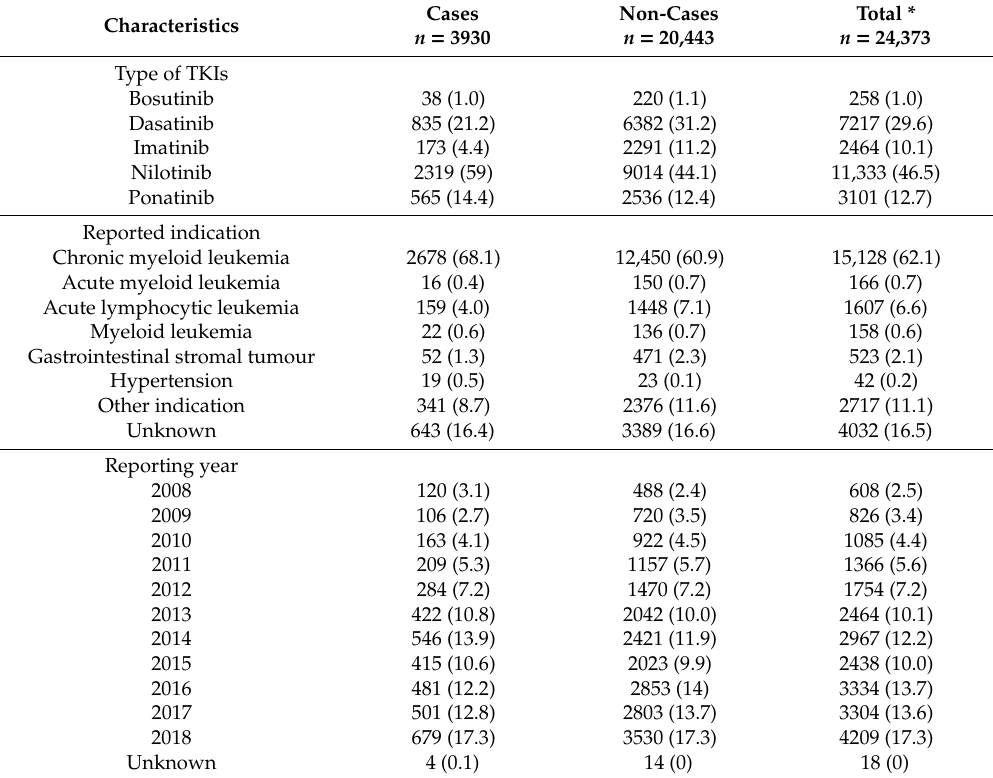
Table 2. Characteristics of cases of cardiovascular toxicity and non-cases submitted for tyrosine kinase inhibitors